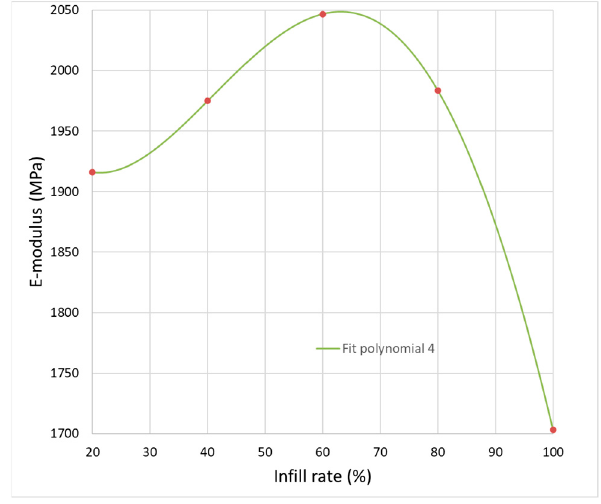
Figure 16. Polynomial fit of the infill rate vs. E-modulus of tensile specimens. Analyzing the obtained equations of the fitting curve: E-modulus/MPa = 2085 – 18.6 Infill rate/% + 0.6307 Infill rate 2 /% 2 − 0.006569